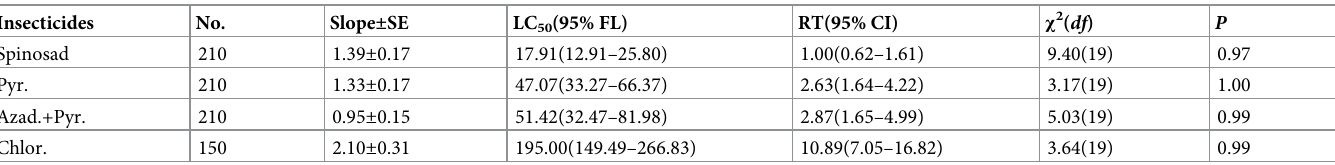
Table 4. Relative toxicity (RT) of insecticides to the 3 rd instar spined soldier bug, Podisus maculiventris in oral toxicity bioassay at 95% confidence interval. Insecticides No.